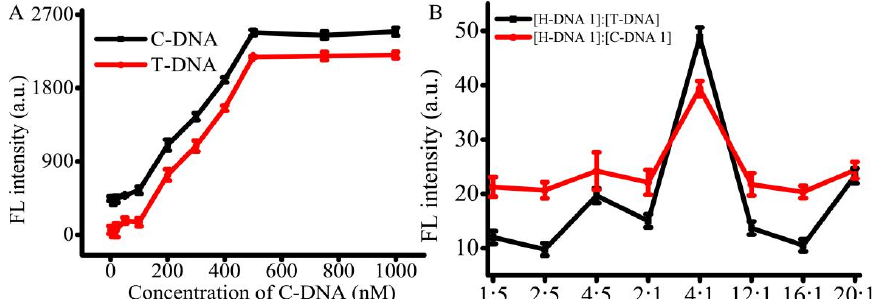
Figure 3. Optimization of DNA conditions. ( A ) FL intensity against various concentrations of C-DNA and T-DNA, and ( B ) various ratios of H-DNA 1 and T-DNA or C-DNA 1.